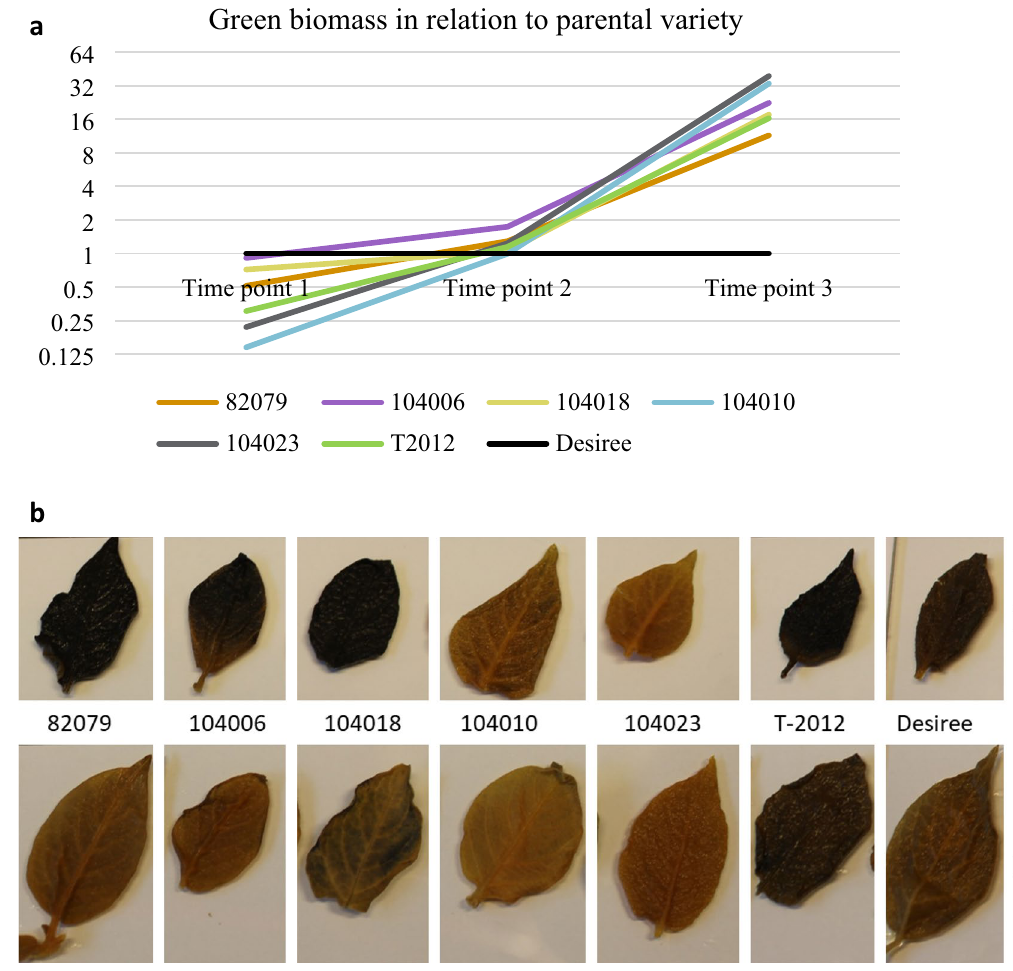
Figure 7. Transitory starch and green biomass of plants grown in greenhouse. Lines analysed are; 82079 (Group 1), 104006 (Group 2), 104018 (Group 2), 104010 (Group 3), 104023 (Group 3), T-2012 and parental variety Desiree. ( a ) Green biomass measured with low-cost RGB imaging phenotyping lab using digiCamControl (digiCamControl v2,1,2, http://www.digic amcon trol.com) and Easy Leaf Area. All lines are normalised to the parental variety Desiree, which is set to 1. The results are a mean of three biological replicates. Note that the vertical axis has a logarithmic scale. ( b ) Leaf tissue of top shoots harvested after a light (top row) and dark period (bottom row) stained with